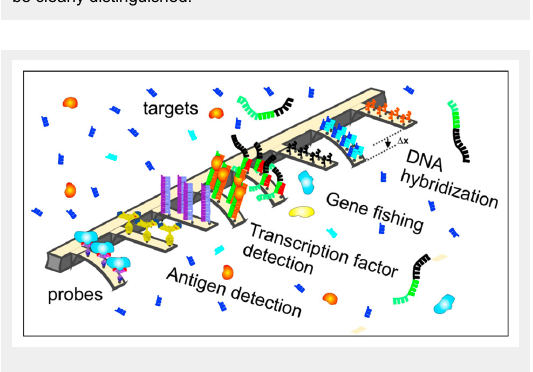
(A) The example of DNA hybridisation to immobilised oligonucleotides illustrates the molecular crowding, which creates a surface stress resulting in cantilever bending. A differential deflection (Δx) can be measured with the help of a reference cantilever. (B) Measurement of total RNA from a BRAF mutated melanoma cell line (red) and from a cell line (black) that does not contain the BRAF mutation. Injection is indicated with a red and black bar at the bottom of the graph. The measurement device is washed with buffer before and after injection. The two cell lines can be clearly distinguished.